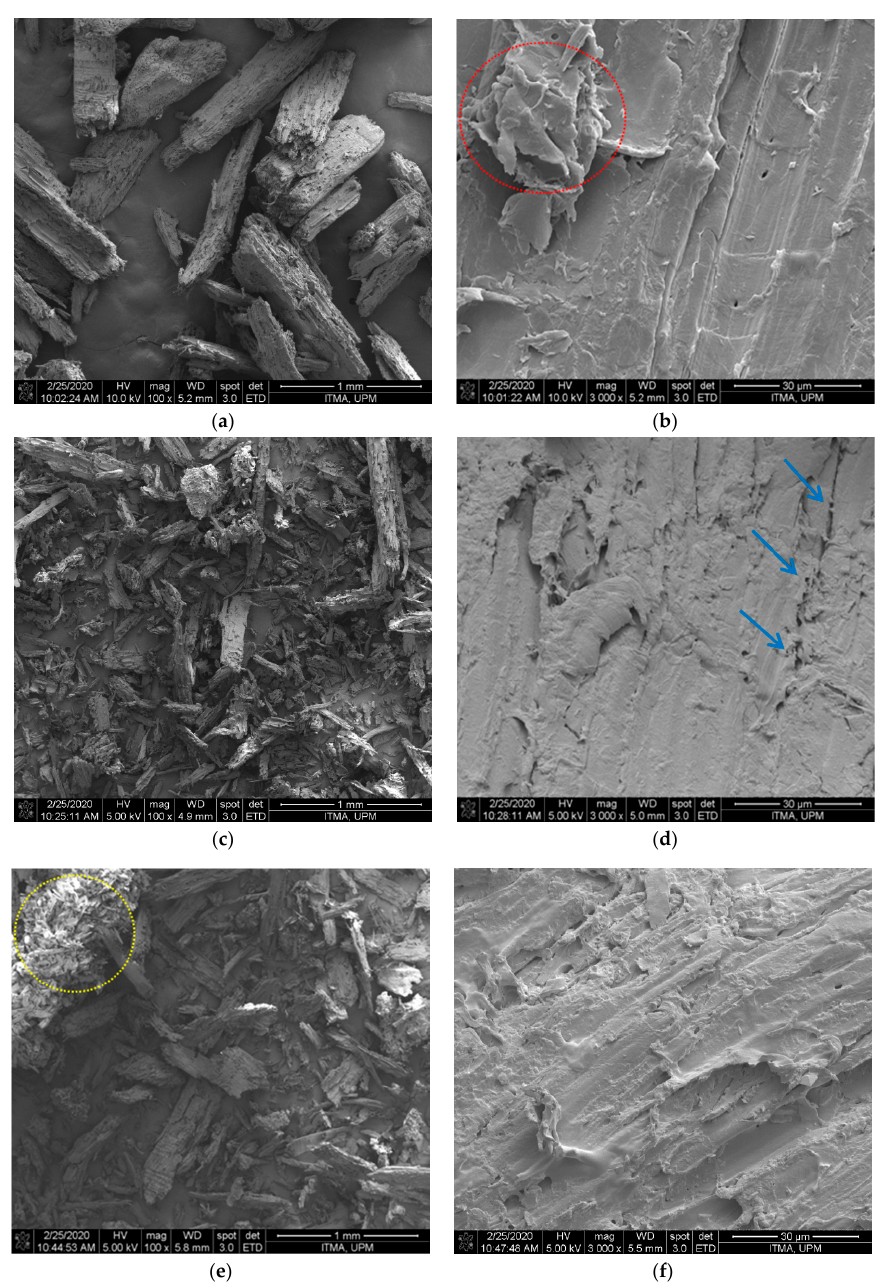
Figure 1. Micrographs of ( a , b ) bleached fibrefiber (CPBLH), ( c , d ) alkali-treated fibrefiber (CPAKL), and ( e , f ) microcrystalline cellulose (CPMCC) with magnifications of × 100 ( a , c , e ) and × 3000 ( b , d , f ) under SEM viewing.